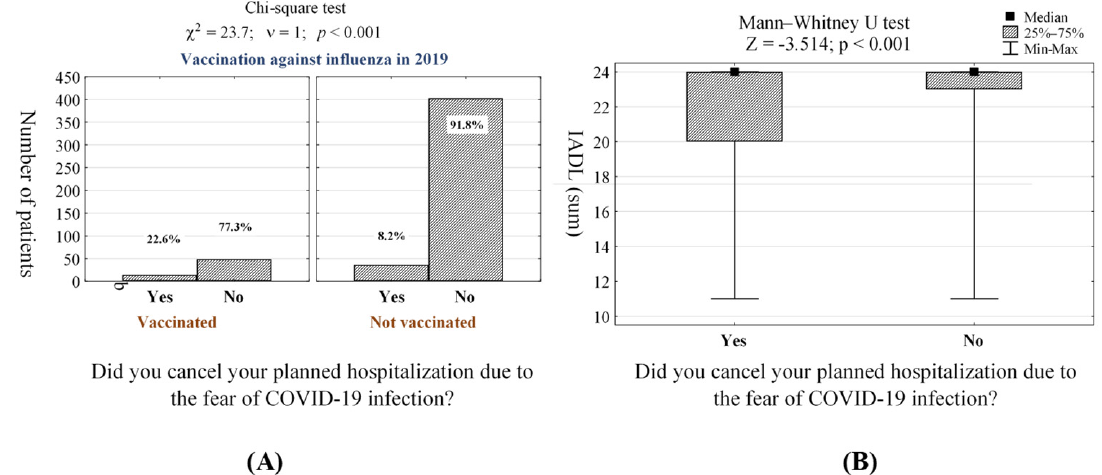
Figure 1. ( A ) Number ( n ) and percentage (%) of elderly patients in groups differing on those vaccinated against influenza or not in 2019, ( B ) Mann–Whitney U test showing the significant correlation between patients who are less fit (according to IADL scale) and canceled planned hospitalization due to the fear of COVID-19 infection.